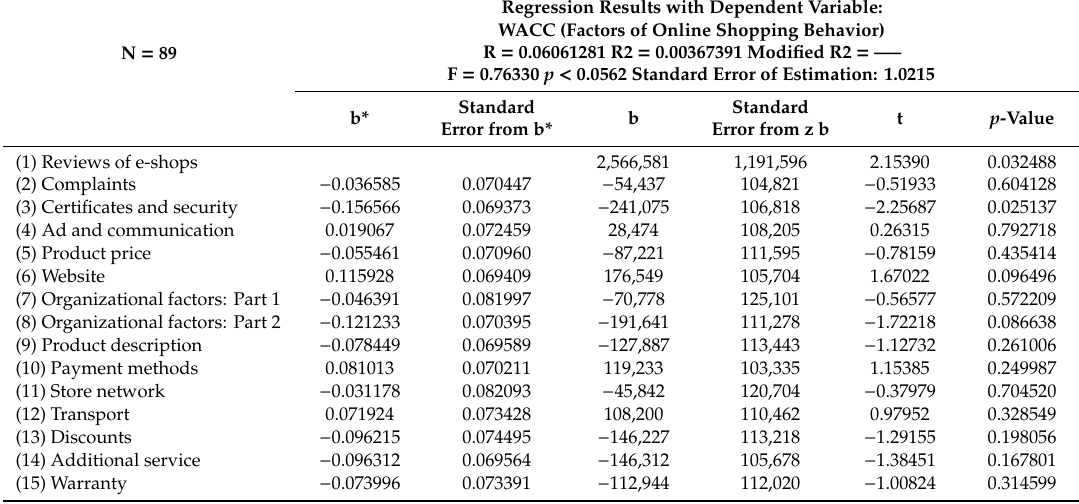
Table 4. Example: Multiple regression between WACC and factors of online shopping behavior. Source: own processing (in the Statistica software). Regression Results with Dependent Variable: WACC (Factors of Online Shopping N = 89